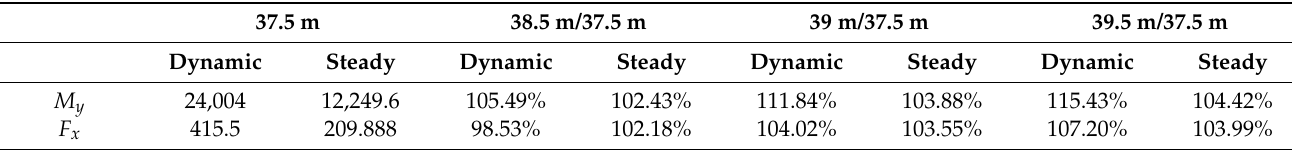
Table 16. The main ultimate loads affected by blade extension on the tower bottom.